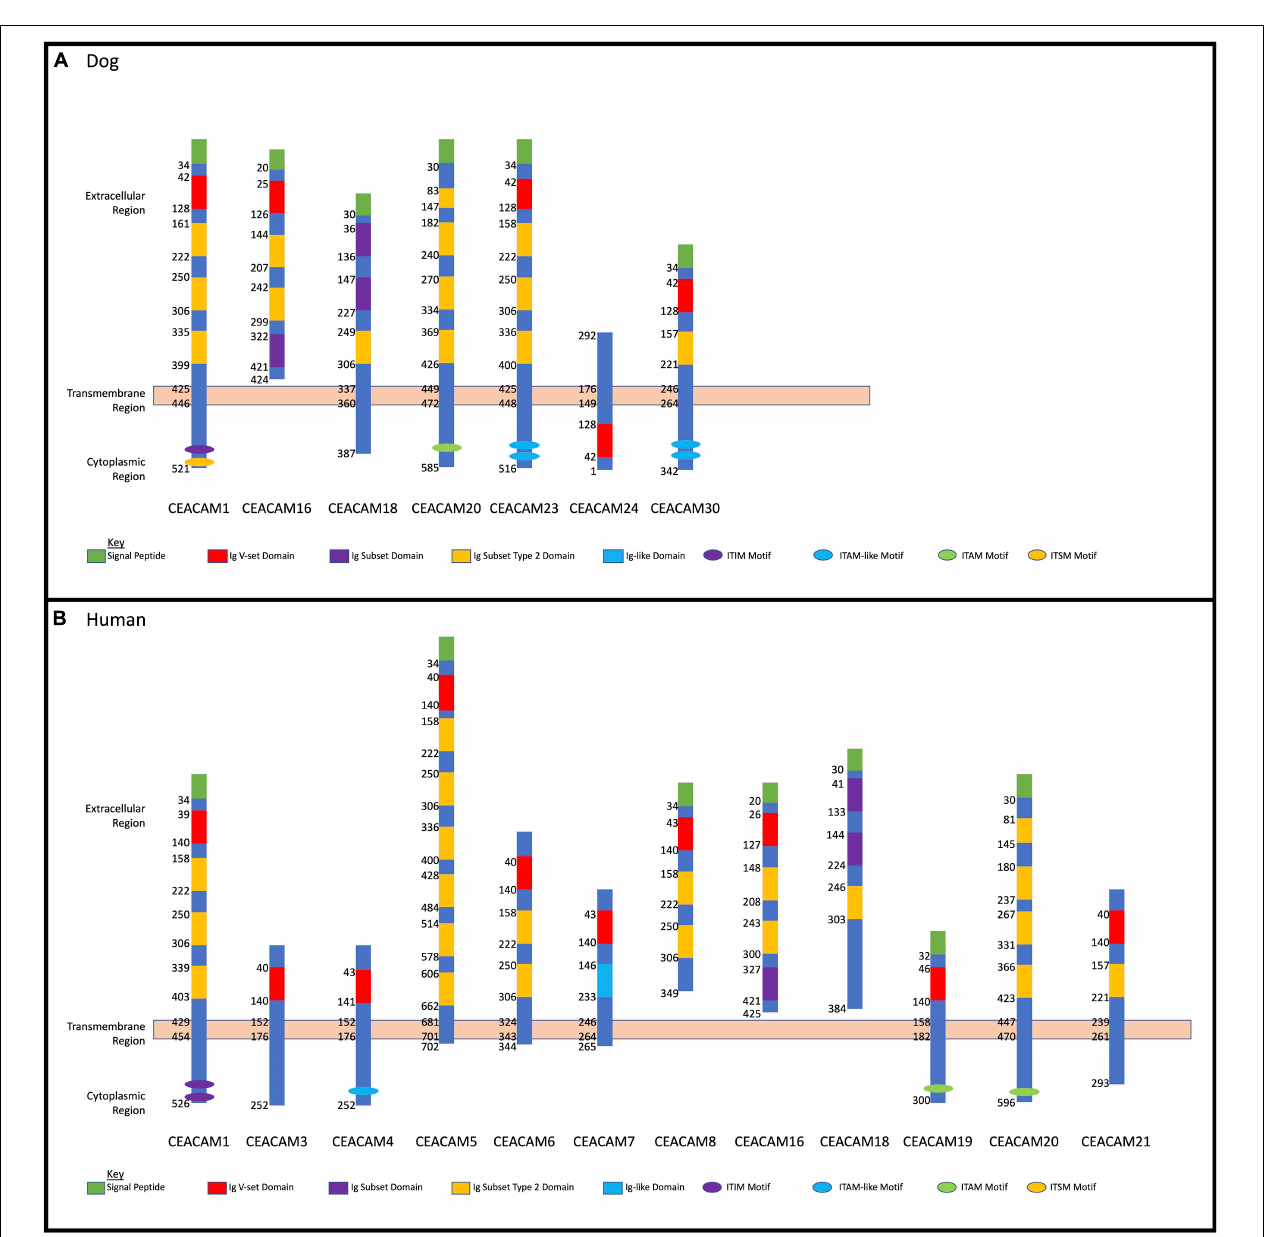
FIGURE 2 | Dog and human CEACAM gene family protein domain analysis. (A) Dog CEACAM protein domain and binding site depictions with membrane regions. (B) Human CEACAM protein domain and binding site depictions with membrane regions.